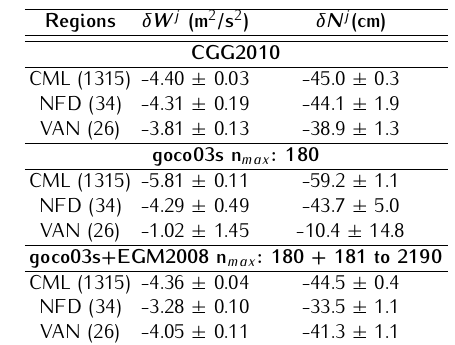
Table 3. Potential and vertical datum offsets and their accuracy for Nov07 vertical datum evaluated with GNSS/levelling bench- marks from CML, NFD, and VAN regions of